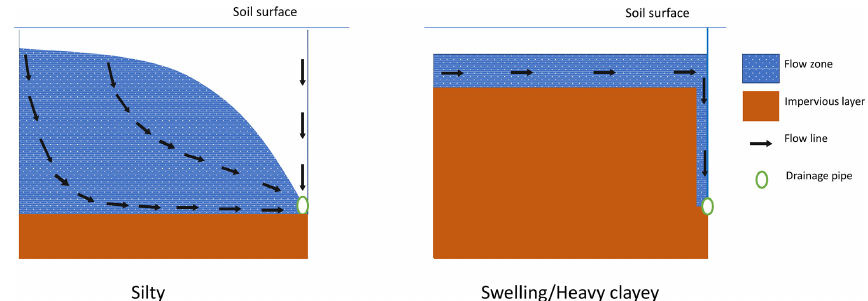
Figure 12. Evolution of the water table shape between a silty and a heavy clayey drained soil, adapted from Bouarfa and Zimmer (2000) and Branger et al.